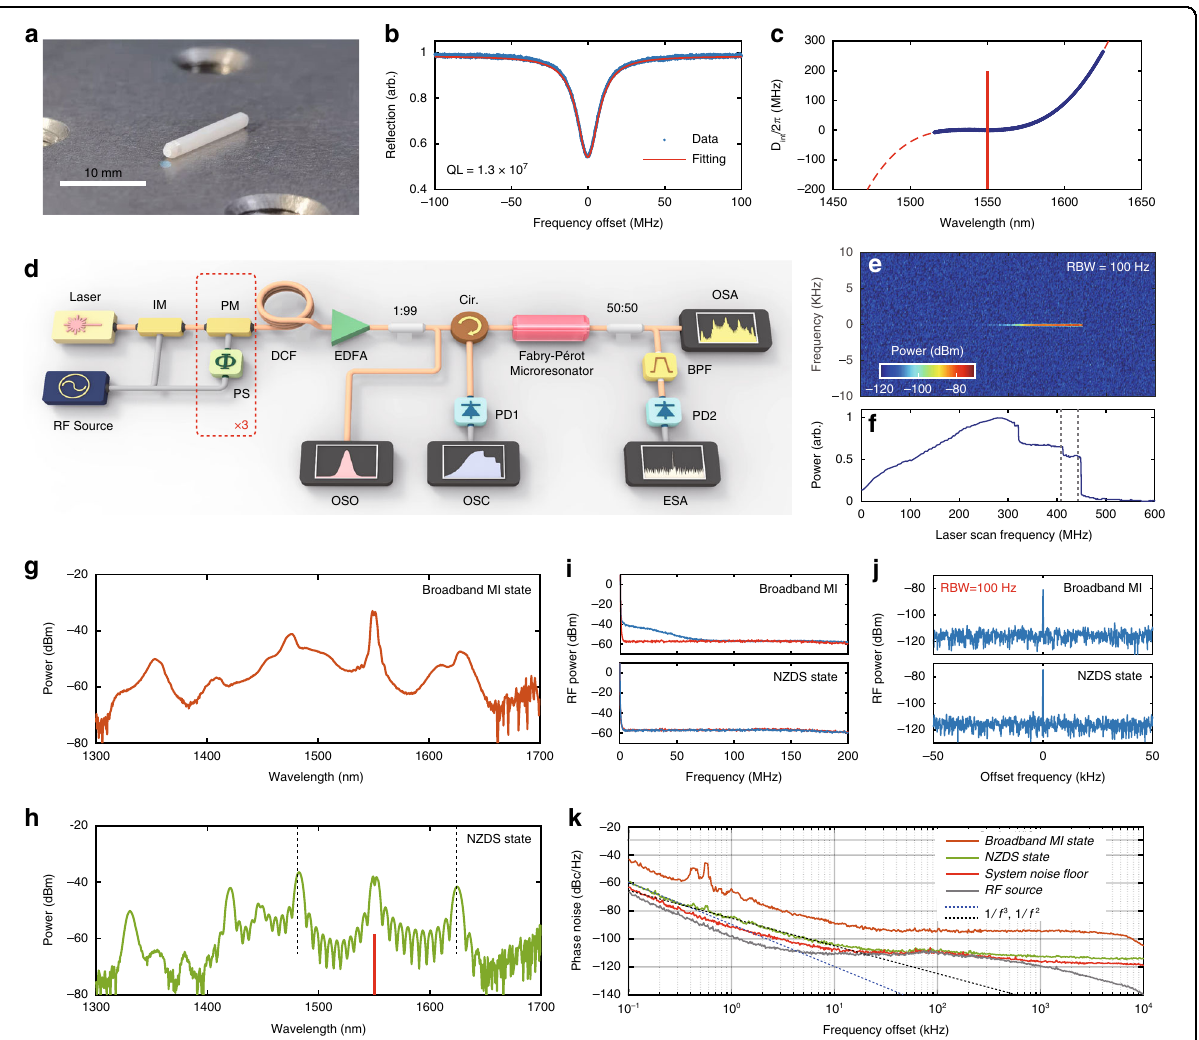
Fig. 3 Experimental AD-NZDS formation via desynchronized pulse driving. a Photograph of the F-P microresonator. b Re fl ective spectrum of the microresonator when the C.W. laser is scan over a resonance near 1550 nm. Blue dots: measured data. Red curve: Lorenzian fi t. c Measured integrated dispersion D int (blue dots) and fi tting curve (red dashed line). The center mode of the driving pulse is indicated by a red solid line. d Experimental setup. IM: intensity modulator, PM: phase modulator, EDFA: erbium-doped fi ber ampli fi er, PS: phase shifter, ESA: electronic spectrum analyzer, DCF: dispersion compensation fi ber, Cir: circulator, PD: photodetector, OSA: optical spectrum analyzer, OSO: optical sampling oscilloscope, OSC: oscilloscope. e Evolution of the repetition-rate beatnote and f resonator transmission versus various laser scan frequency. The gray-dashed lines mark the measured detuning positions in ( g ) and ( h ). Spectral pro fi les of g broadband MI state, and h NZDS state. The black-dashed lines mark the position of prominent combs, and red-solid line marks the position of pump envelope. i Intensity noise (blue) in the broadband MI and NZDS states. The ESA noise fl oor is in red curves. j Repetition-rate beatnote signal in the broadband MI and NZDS state. k Phase noise spectra of broadband MI state (orange) and NZDS state (green), along with the phase noise of RF source (gray) and system noise fl oor